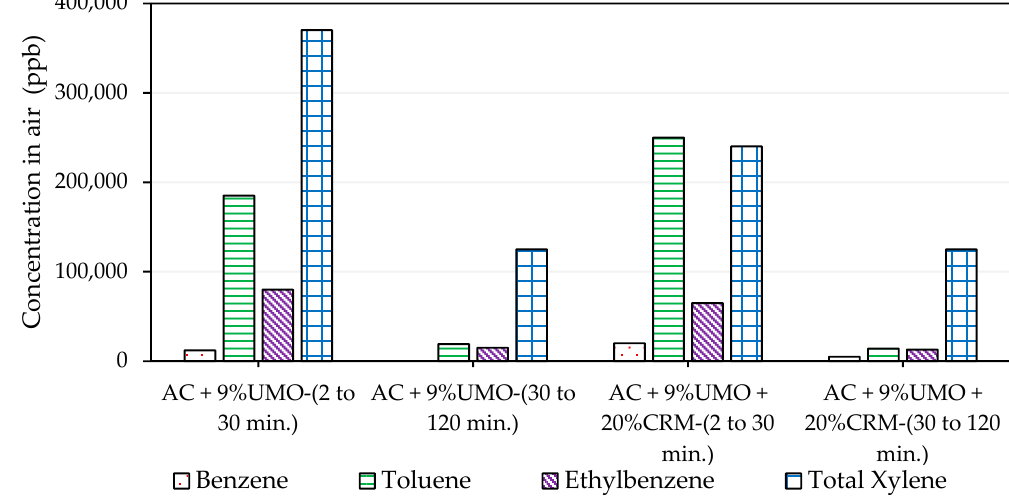
Figure 17. BTEX in air above PG 64-22 modified asphalt binder samples interacted at 190 °C—30 Hz and different interaction times [15].